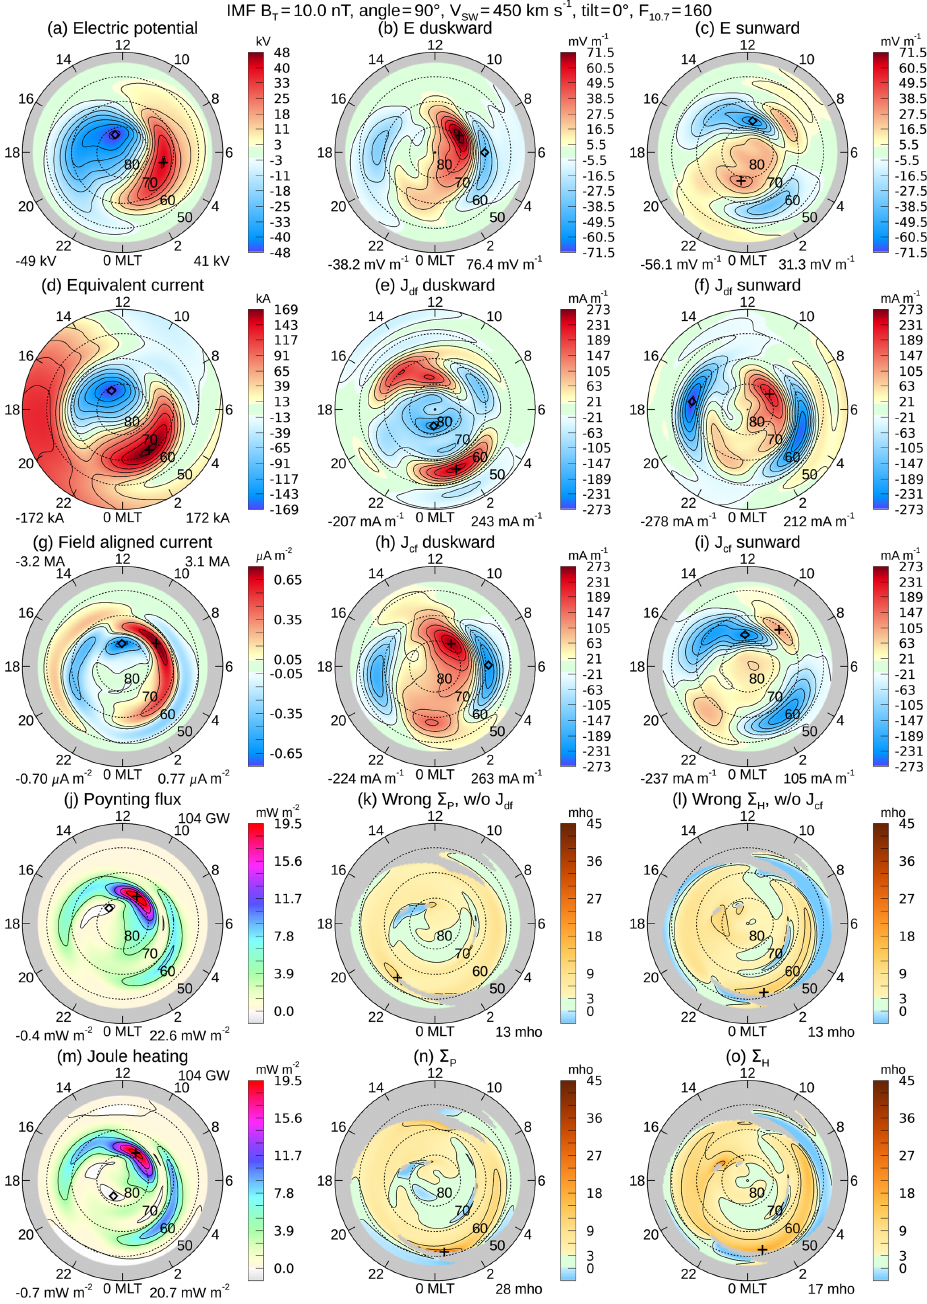
Figure 4. Conductivity input data and results for the same conditions as in Fig. 1, except that IMF clock angle is changed 90 ◦ . The IMF B T magnitude is 10nT, the solar wind velocity is 450km s − 1 , the F 10 . 7 index is 160sfu, and the dipole tilt angle is 0 ◦